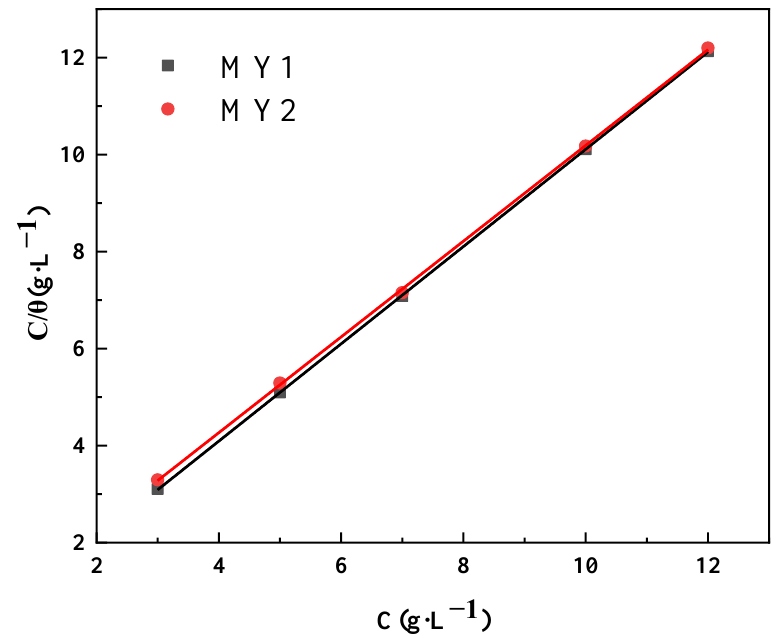
Table 4. Thermodynamic adsorption parameters.